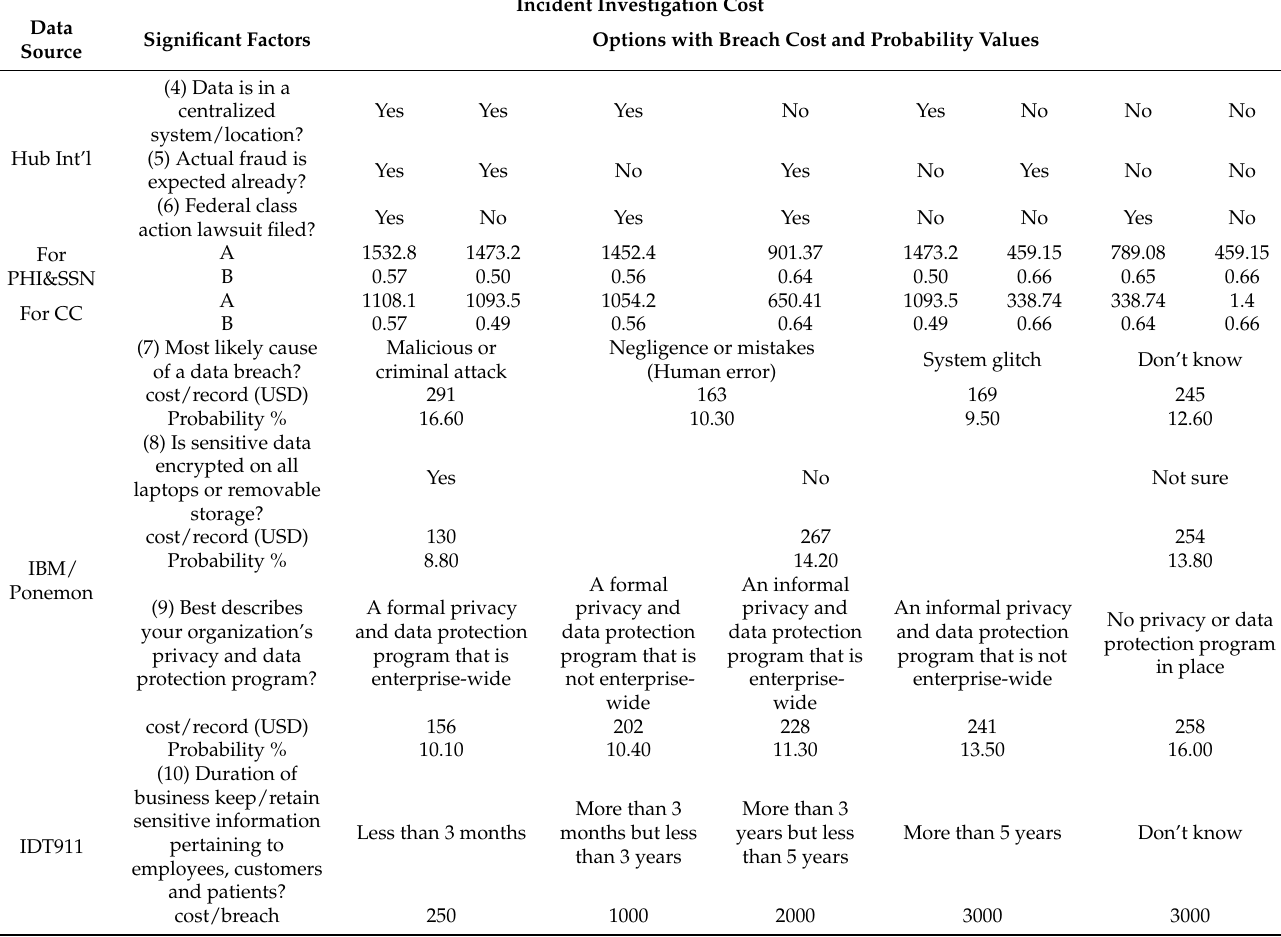
Table 5. The parameters a and b, the values of data breach costs, and the probabilities for the factors associated with incident investigation cost.